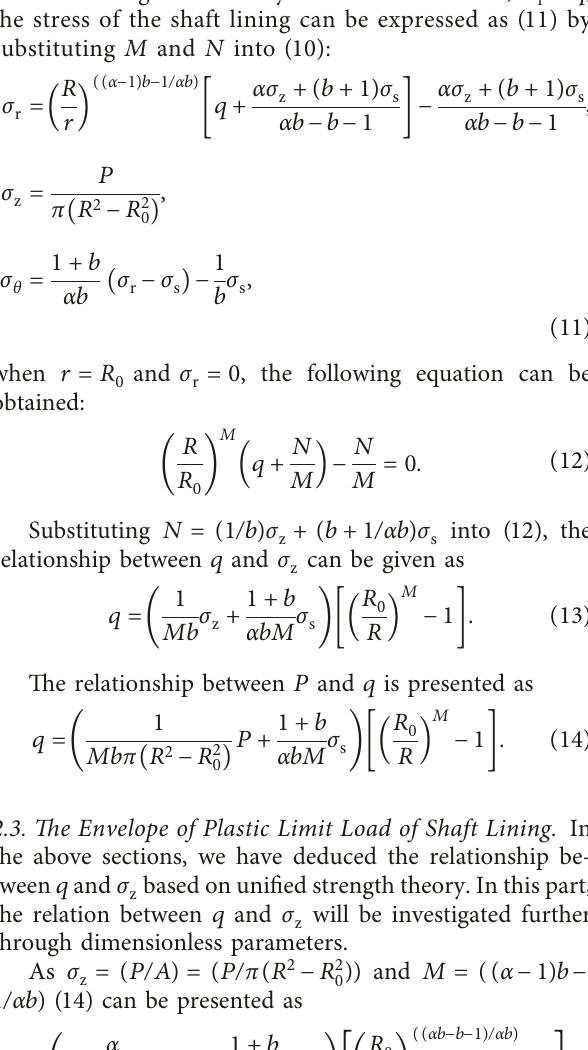
Figure 2: Envelope line of plastic limit loads of the shaft